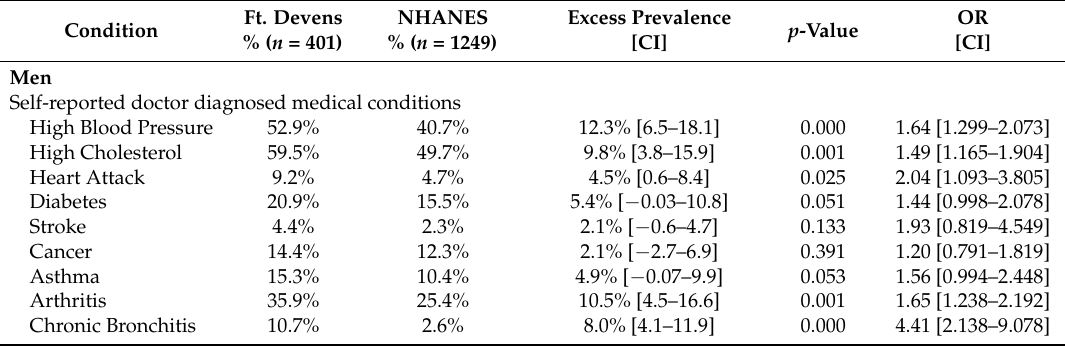
Table 2. Cohort comparison of prevalence of medical conditions—non-restricted